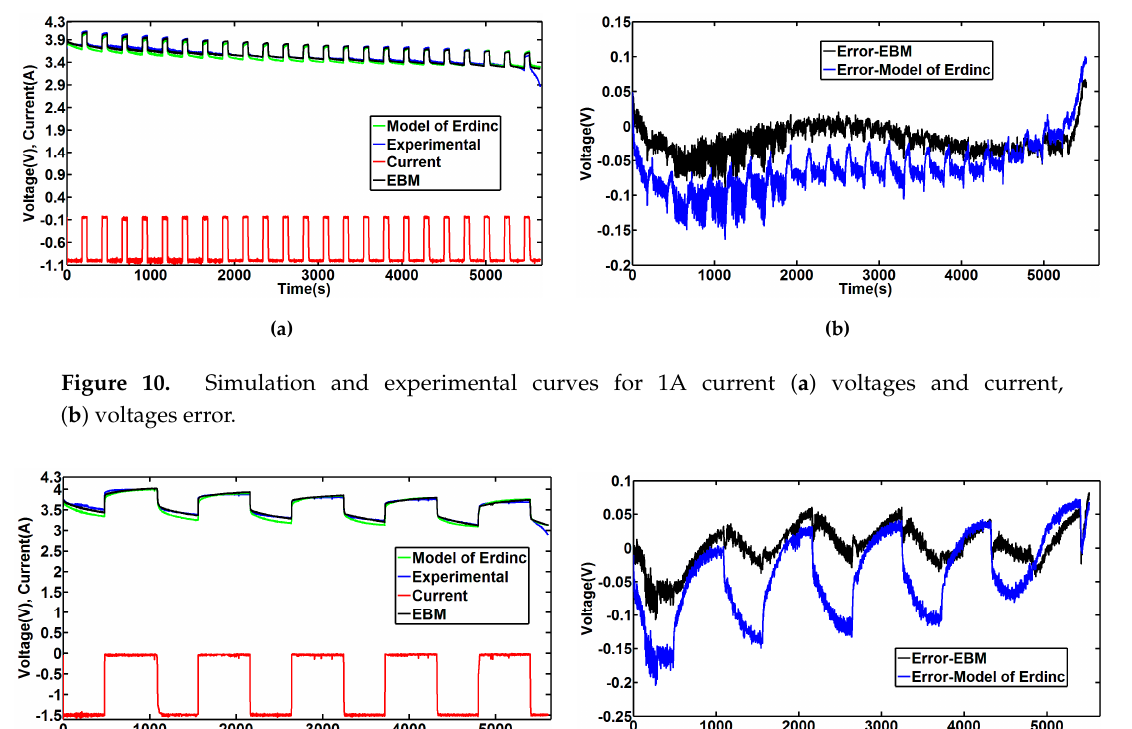
Figure 9. Simulation and experimental curves for 0.8 A current ( a ) voltages and current, ( b ) voltages error.